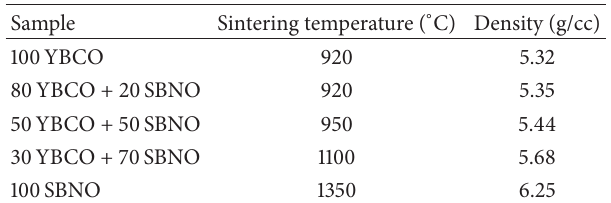
Table 1: Sintering temperature and density of YBCO-SBNO com-